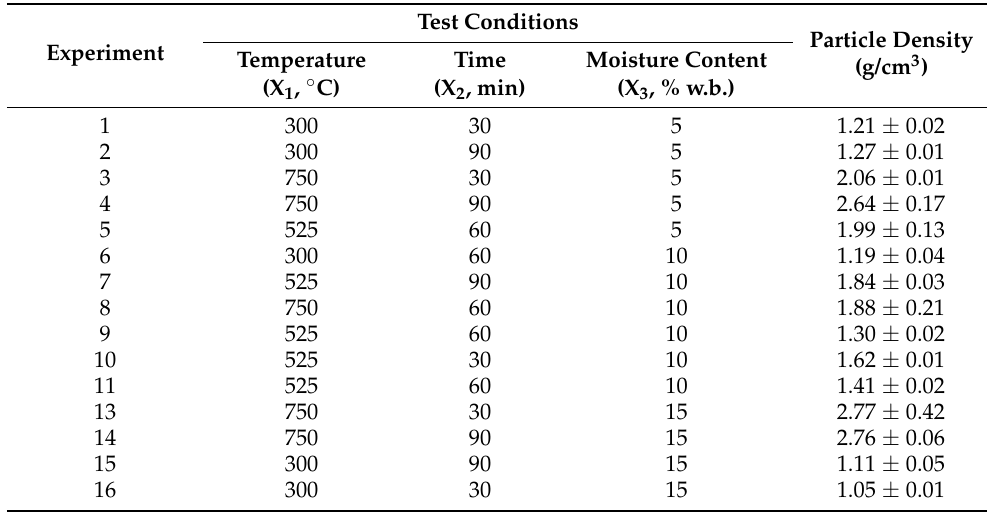
Table 5. Particle densities of laboratory-produced biochars.